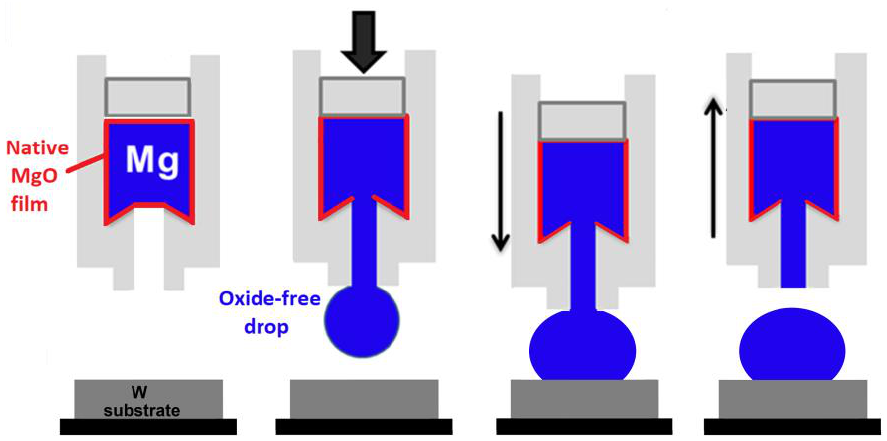
Figure 3. A scheme of the high-temperature wettability test using the sessile drop method with non-contact heating and capillary purification procedure.